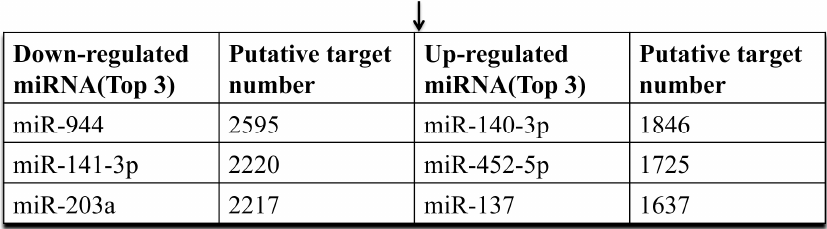
Figure 1. Research strategy of miR-944 screening in NSCLC cell lines.